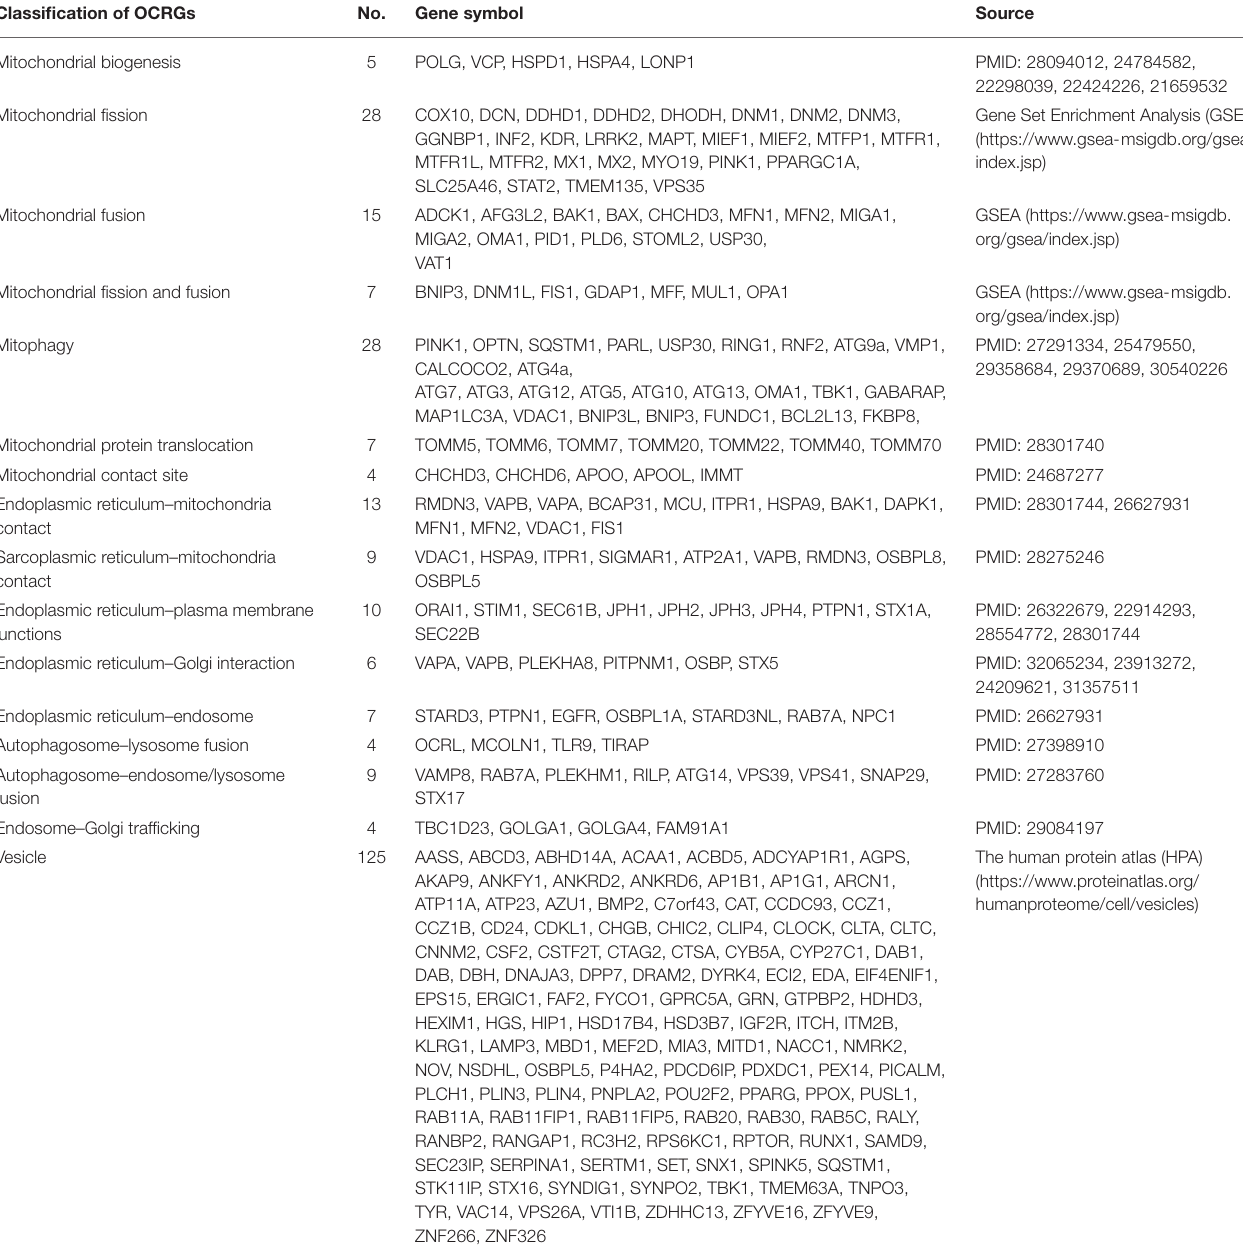
TABLE 1 | Two hundred sixty organelle crosstalk regulators (OCRGs) were searched from three databases such as National Center for Biotechnology Information (NCBI), Gene Set Enrichment Analysis (GSEA), and the Human Protein Atlas (HPA) website. Classification of